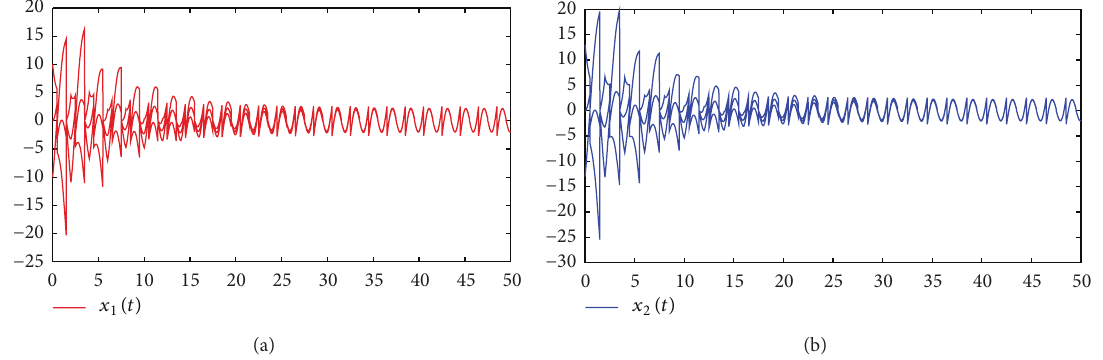
Figure 1: Numerical solutions 𝑥(𝑡) = (𝑥 1 (𝑡),𝑥 2 (𝑡)) 𝑇 of system (1) for initial value 𝜑(𝑡) ≡ (10,−13) 𝑇 , (−10, 13) 𝑇 , (0,0) 𝑇 , 𝑡 ∈ (−∞, 0]